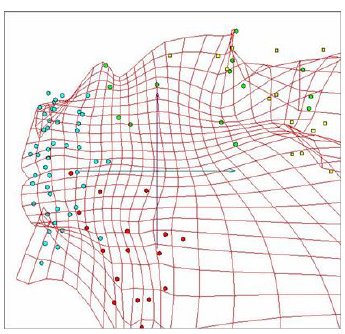
Figure 5. Elastic map for source data